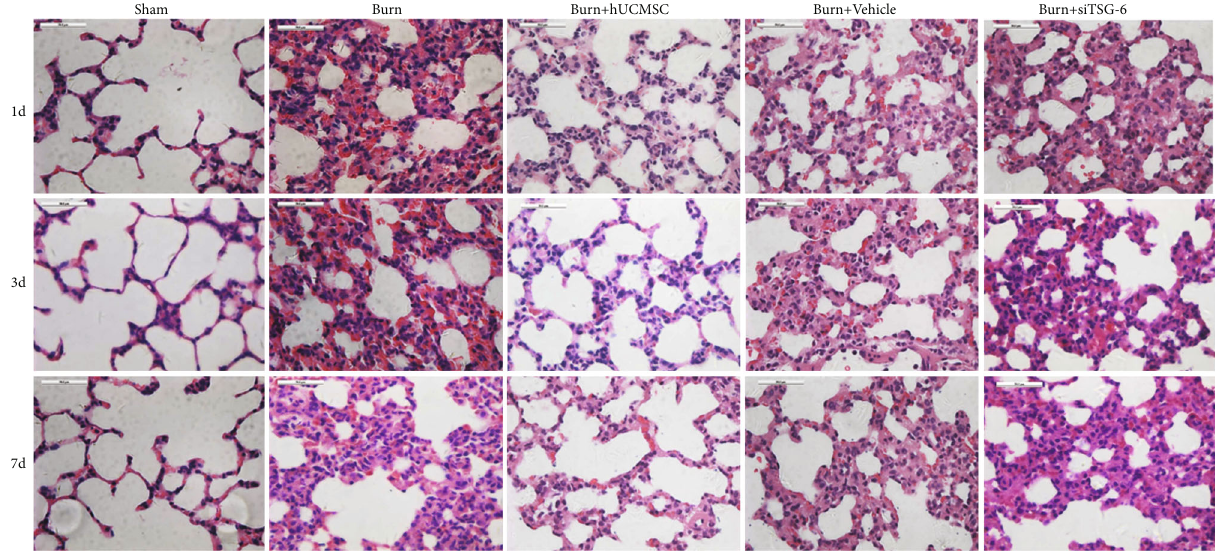
Figure 2: E ff ect of TSG-6 on the structural damage and total in fl ammatory cell in fi ltrations of lung tissues induced by severe burn. Representative photographs of lung tissues in all groups using H&E staining are shown (the light microscope,